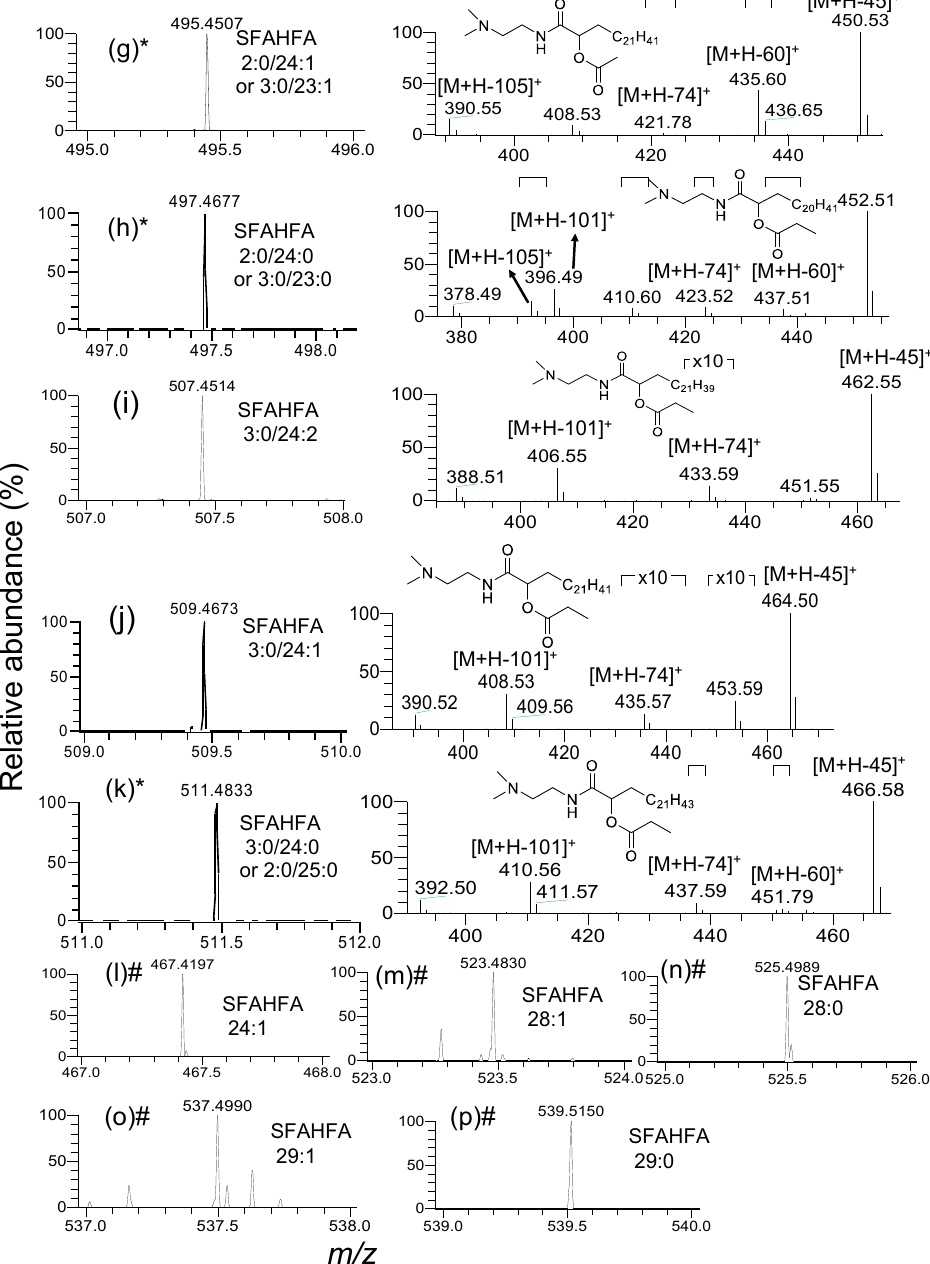
Figure 4. Mass spectra (MS 1 ) of DMED-labeled SFAHFAs and their acquired MS / MS spectra along with tentative chemical structures ( g – p ). (* represents the isomeric mixtures and # represents the SFAHFAs for which MS/MS are not shown).